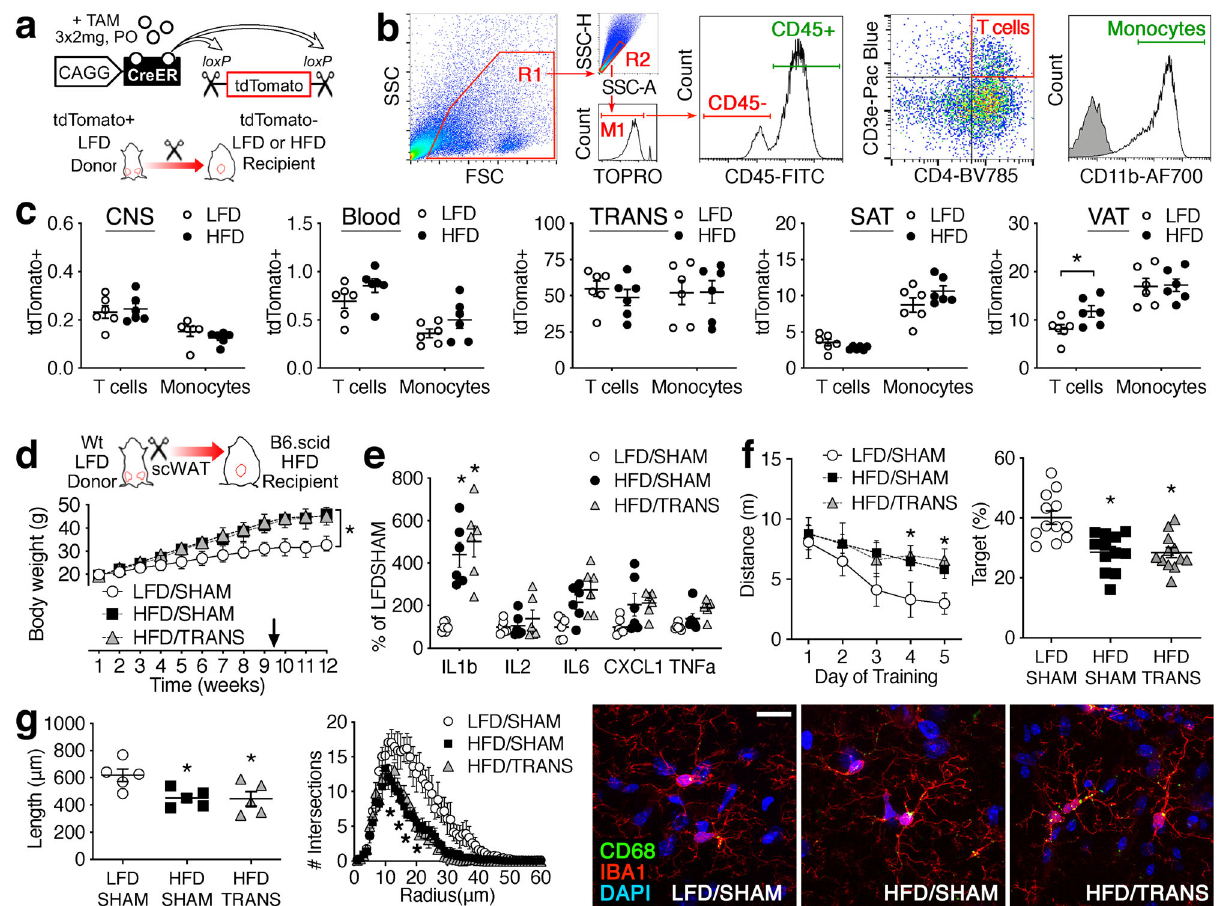
Fig. 6 Recipient lymphocytes are required for the effects of SAT transplantation on cognition. a Top panel shows a schematic of transgenic mice with inducible ubiquitous expression of tdTomato. Reporter mice were used as subcutaneous fat donors for wildtype (Wt) recipients on a low-fat or high-fat diet (LFD, HFD). b Gating strategy for analysis of lymphocyte traf fi cking in forebrain mononuclear cells and stromal – vascular fraction (SVF) from resident and transplanted adipose tissue. c tdTomato + T cells (CD45 − /CD3e + /CD4 + ) and monocytes (CD45 + /CD11b + ) were rare in the central nervous system (CNS) of transplant recipients, and their frequency was unaffected by recipient diet. Donor-derived T cells and monocytes were also rarely detected in lysed whole blood, and there was no effect on the recipient diet. Numerous viable tdTomato + T cells and monocytes were detected in SVF from subcutaneous fat transplants (TRANS). A smaller population of tdTomato + cells was detected in resident subcutaneous adipose tissue (SAT), with no effect of diet. In epididymal visceral adipose tissue (VAT), dietary obesity was associated with the accumulation of tdTomato + T cells. For each graph, symbols represent individual LFD recipients (white circles) or individual HFD recipients (black circles). Lines show mean ± sem from ( n = 6) mice/ condition. d Top panel shows the experimental design for SAT transplantation experiments in B6.scid mutant mice. Bottom graph shows weight gain in B6. scid mutant mice on LFD or HFD, with the sham operation or SAT transplantation from a Wt donor during week 9 of the experiment (arrow). Symbols represent mean ± sem ( n = 12 mice/condition). For d – g , white circles represent LFD/SHAM; black circles, HFD/SHAM; gray triangles, HFD/TRANS. e Multiplex analysis of serum cytokines in B6.scid mice. Symbols represent individual mice and lines show mean ± sem ( n = 6 mice/condition). f Persistent de fi cits in water maze acquisition (left) and probe trial performance (right) in B6.scid mice after SAT transplantation. For acquisition (left), symbols represent group mean ± sem; for probe trial (right), symbols represent individual mice and lines show mean ± sem ( n = 12 mice/condition). g Comparable reductions in microglial process length (left) and complexity (right) in HFD/SHAM and HFD/TRANS B6.scid mice. For process length (left), symbols represent individual mice and lines show mean ± sem ( n = 5 mice/condition). For complexity (right), symbols indicate group mean ± sem from ( n = 5) mice/condition. For both graphs, (5) cells were analyzed from each mouse. Micrographs (far right) depict representative images of IBA1 + microglia in the hippocampal dentate molecular layer. Scale bar (LFD/SHAM) = 20 microns and applies to all. c * p < 0.05, bidirectional t -test. For d , f [left], repeated- measures ANOVA; for e , f [right], g [left], one-way ANOVA; * p < 0.05 relative to LFD/SHAM determined by Tukey ’ s multiple comparison test or Dunnett ’ s T3 for heterogeneity of variance. For data, statistics, and exact p -values, see Source Data File